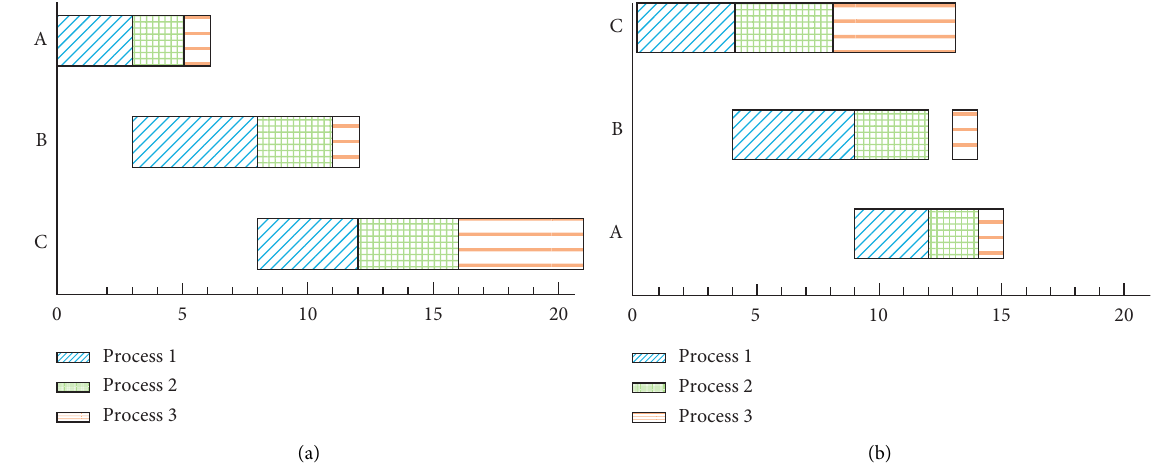
Figure 2: (a) Production sequence scheme (1) and (b) production sequence scheme